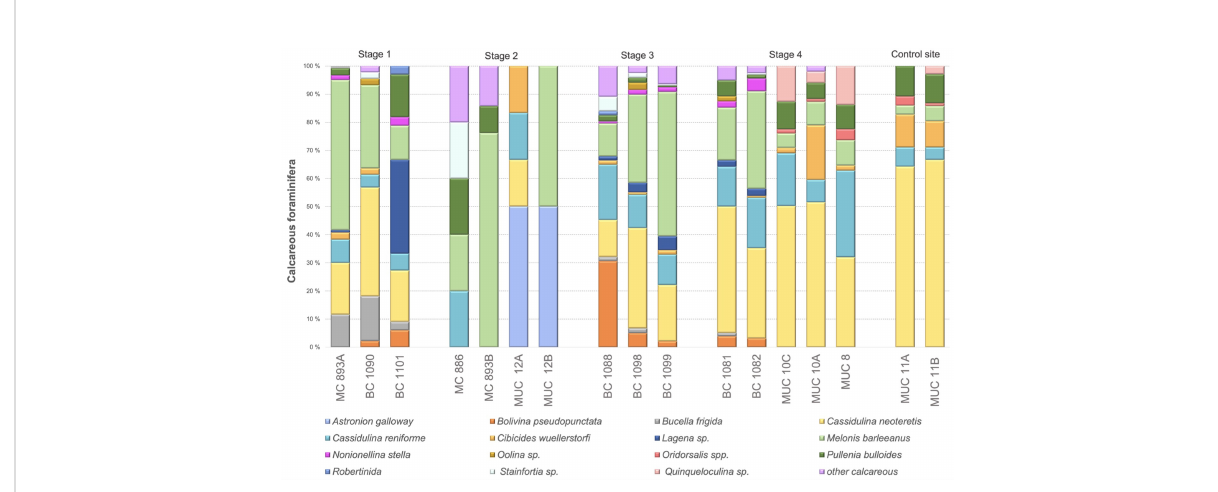
FIGURE 5 Percentage of Rose Bengal-stained calcareous foraminiferal species (direct count).